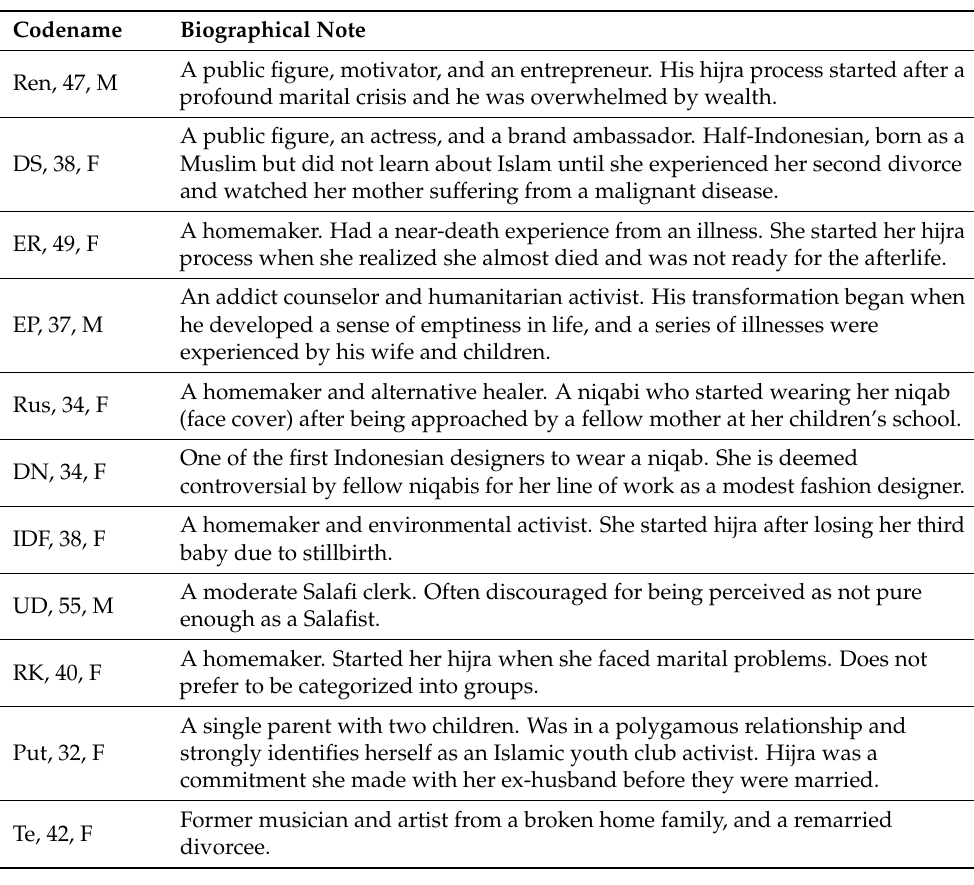
Table 1. Interview Respondents (Aliases Are Used to Ensure